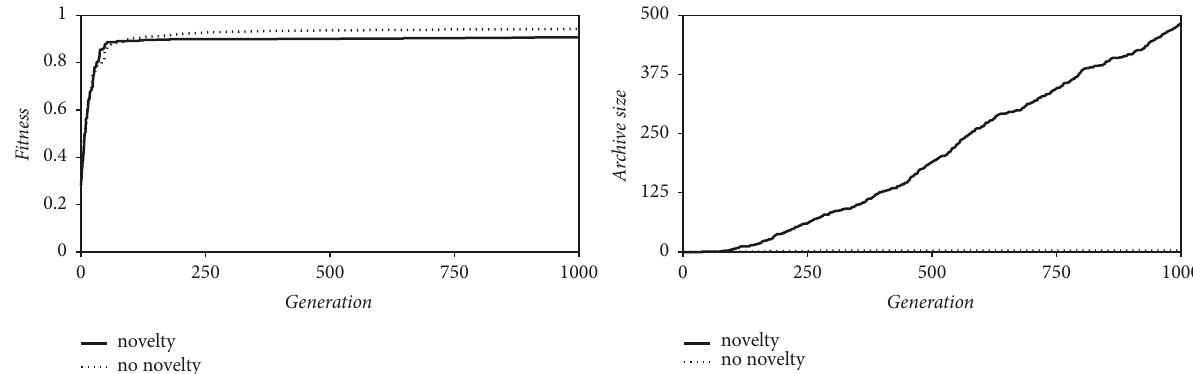
Figure 11: On the left, the progression of the fitness and features’ values of the fitteststencil across generations using the novelty and no novelty setups. On the right, the evolution of the archive size across generations. The visualised results are from a single run.